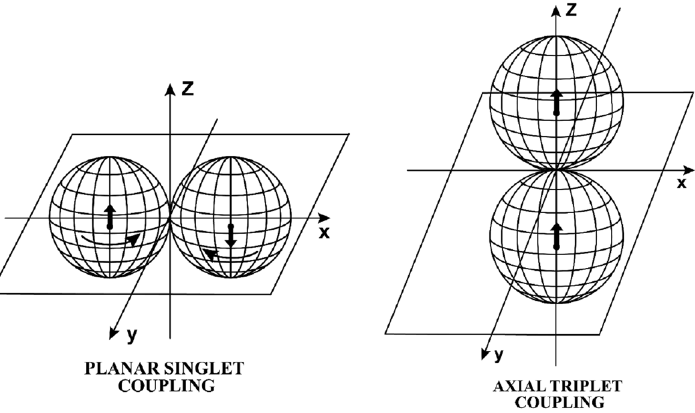
Figure 2. In this figure, we illustrate the sole stable couplings predicted by hadronic mechanics for nuclear fusions (see Fig. 3, p. 152, of Ref. 42 ), which include: the conventional singlet coupling with a plane symmetry and antiparallel spins (on the left) called ‘planar singlet coupling’; and the novel triplet coupling with a symmetry axis and parallel spins (on the right) called ‘axial triplet coupling’. The remaining possible couplings (which are given by the planar triplet with parallel spins and the axial singlet with antiparallel spins not shown in this figure) have been proved to be unstable, and therefore are ignored for nuclear fusions 42 .